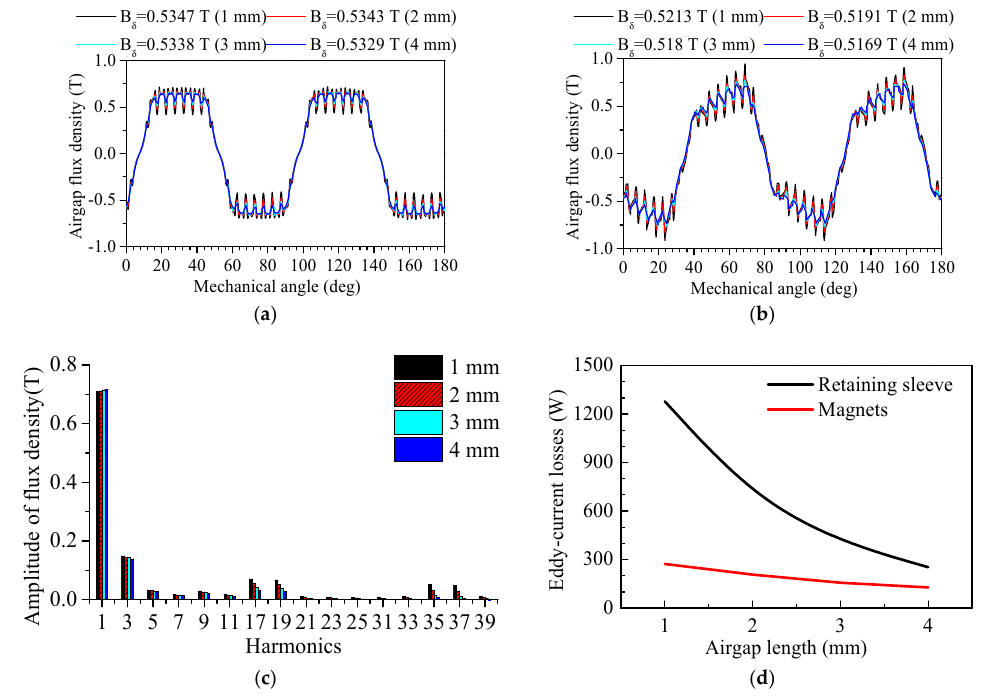
Figure 5. Distribution of radial airgap flux densities at the surface of the rotor with different thickness of magnets ( a ) at no load; ( b ) at rated load; ( c ) harmonic spectrum of the radial airgap flux density at rated load; ( d ) eddy-current losses of retaining sleeve and magnets versus airgap length at rated load.